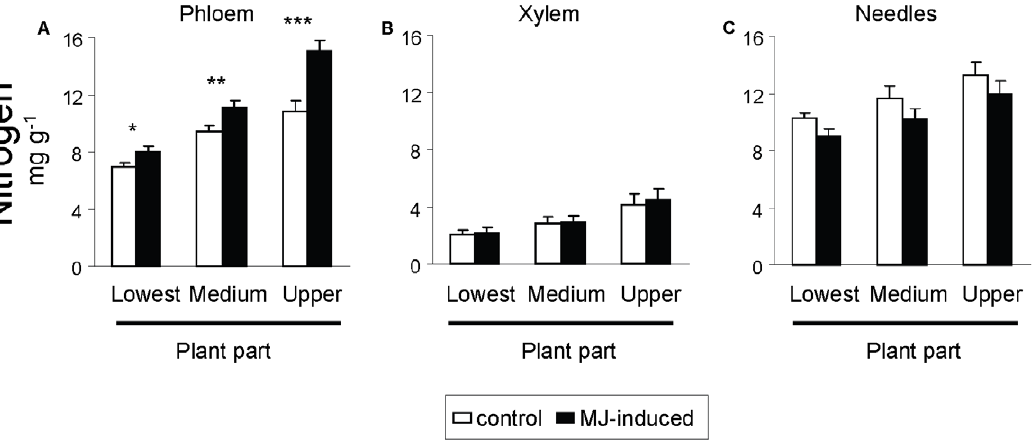
Figure 3. Allocation of constitutive and induced concentration of nitrogen across different pine parts. Nitrogen concentration in (a) the phloem, (b) the xylem and (c) the needles across three parts of the plants (basal, middle and apical upper part) in control (constitutive, white bars) and methyl jasmonate (MJ) induced (black bars) P. radiata juveniles. Plants were destructively sampled 15 days after application of MJ. Bars are means 6 s.e.m. (N=12 for phloem and needle tissues and N=6 for xylem tissue). Asterisks indicate significant differences within each plant part due to MJ- induction at P , 0.05 (*), P , 0.01 (**) and P , 0.001 (***).